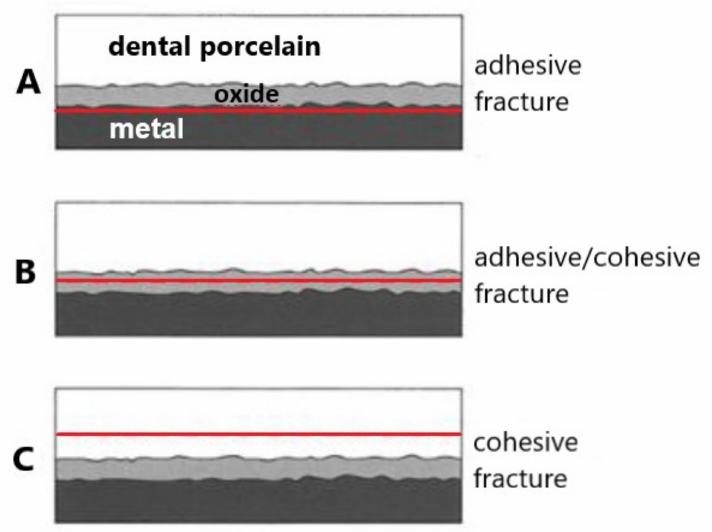
Figure 5. Fracture types of the Ti 99.2–Duceratin Kiss porcelain bond, ( A ) metal–oxide layer, ( B ) oxide layer–oxide layer, ( C ) porcelain layer–porcelain layer [53].